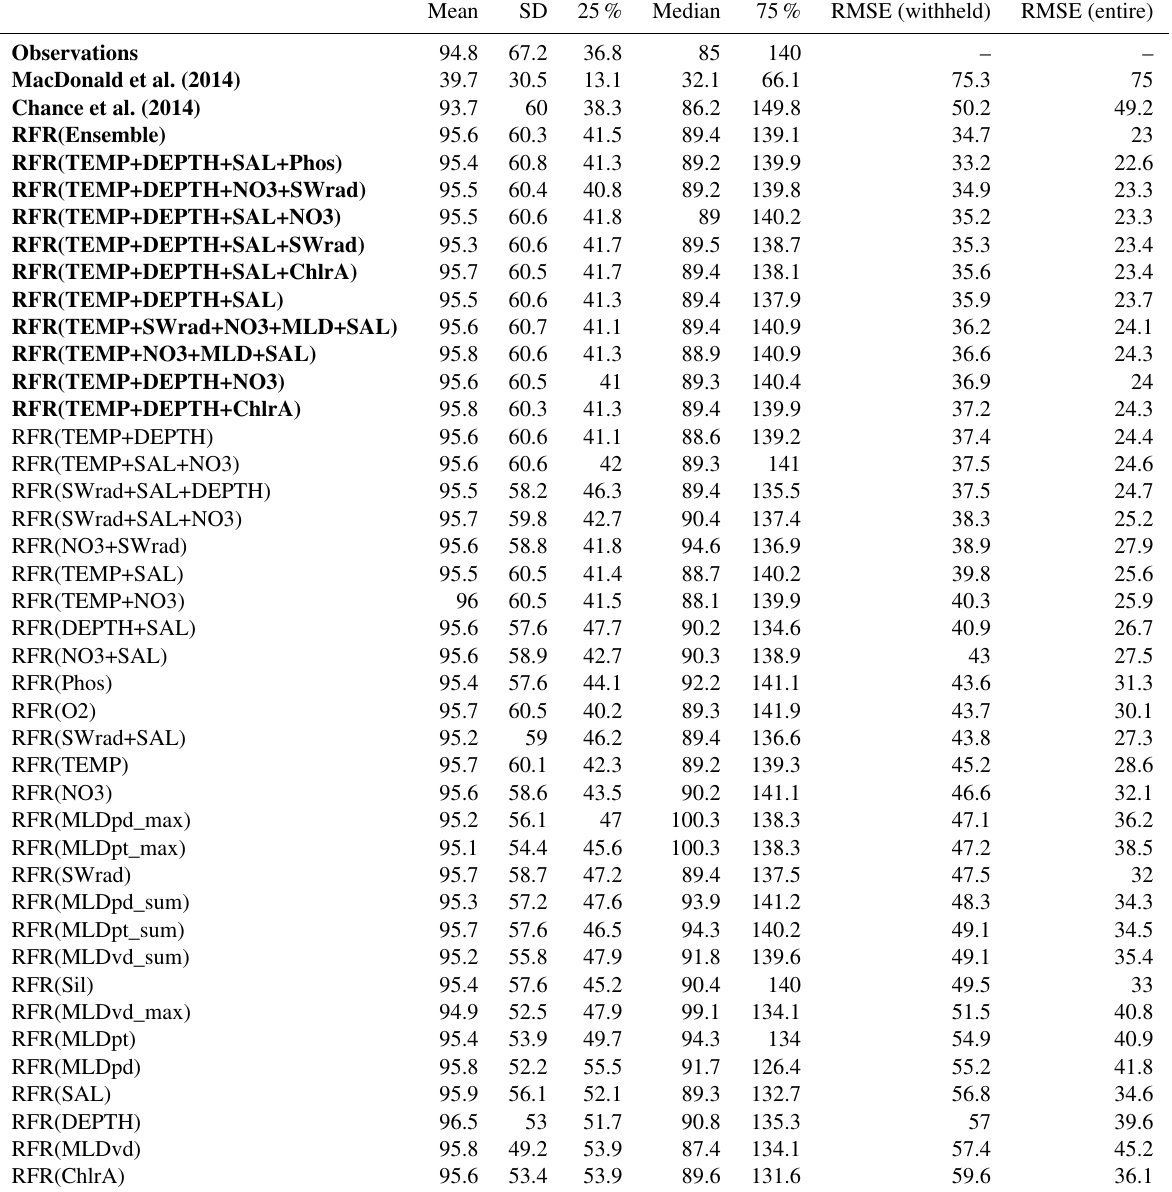
Table A2. Statistics on observations and predicted values from the new ensemble and existing parameterisations at locations of observations. Root mean square error (RMSE) is shown against the withheld data and the entire dataset of observations. Ensemble members, ensemble prediction (RFR(Ensemble)), and existing parameterisations shown in bold. Values are shown for all 38 models built, including those not included in the ensemble.